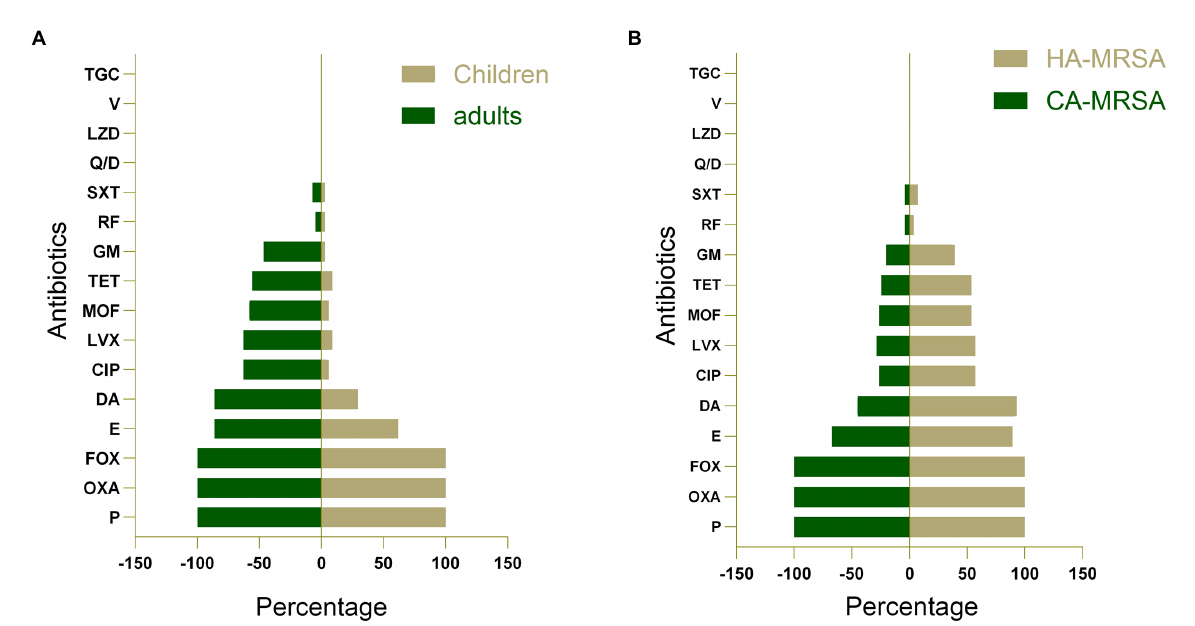
FIGURE 1 (A) A comparison of antimicrobial resistance profiles of methicillin-resistant S. aureus (MRSA) isolates obtained from adults and children. (B) A comparison of antimicrobial resistance profiles of community-acquired MRSA (CA-MRSA) and hospital-associated MRSA (HA-MRSA) isolates. P, penicillin; OXA, oxacillin; E, erythromycin; DA, clindamycin; CIP, ciprofloxacin; LVX, levofloxacin; MOF, moxifloxacin; TET, tetracycline; GM, gentamicin; RF, rifampicin; SXT, trimethoprim-sulfamethoxazole; Q/D, quinupristin/dalfopristin; LZD, linezolid; V, vancomycin; TGC, tigecycline; FOX,